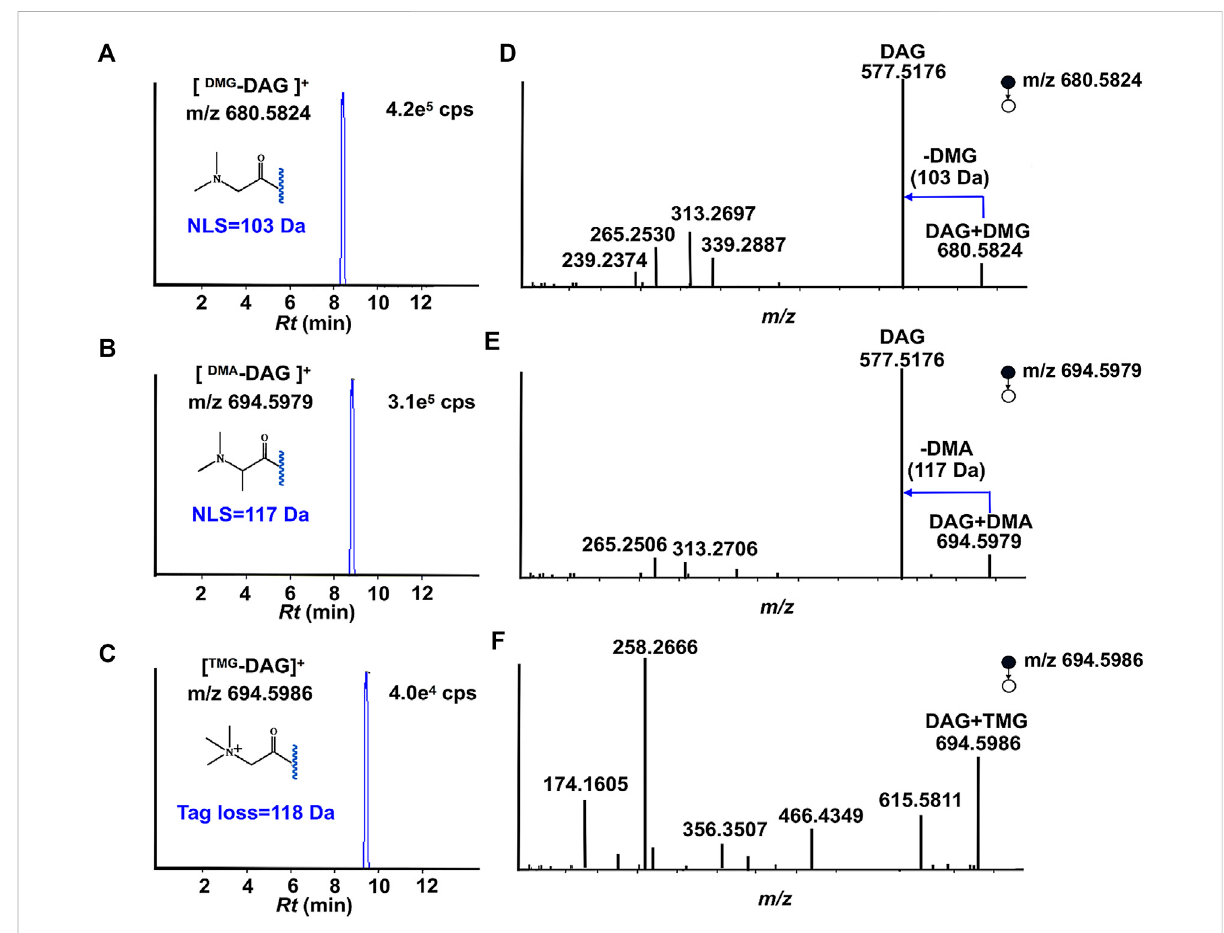
FIGURE 2 Proposed structures for fragments resulting from CID of Tag -DAG. (A,D) : DMG; (B,E) : DMA; (C,F) :